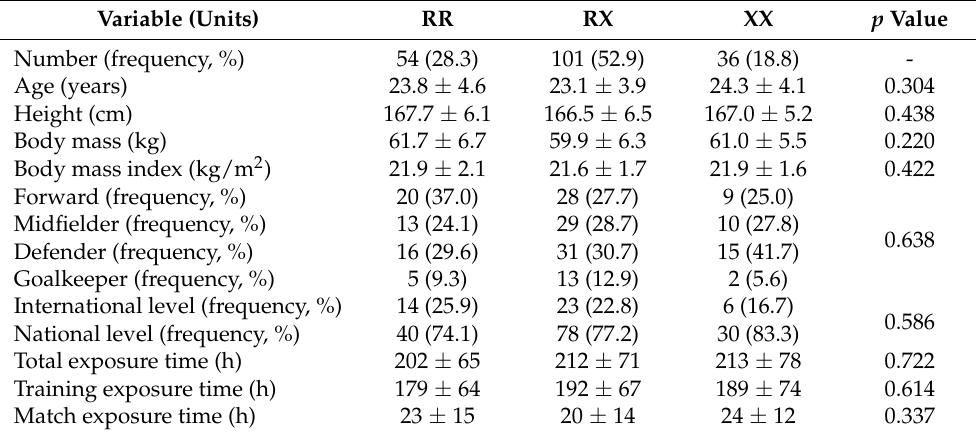
Table 1. Age, anthropometric characteristics, field position, level, and football exposure of women football players competing in the first division of Spanish football according to their ACTN3 R577X